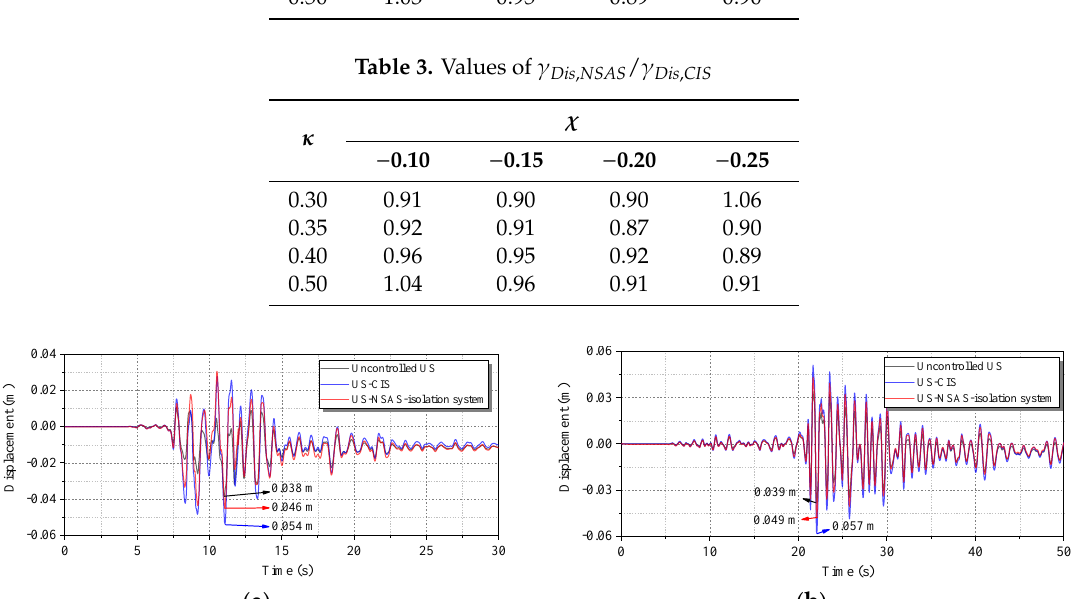
Table 3. Values of γ Dis , NSAS / γ Dis , CIS